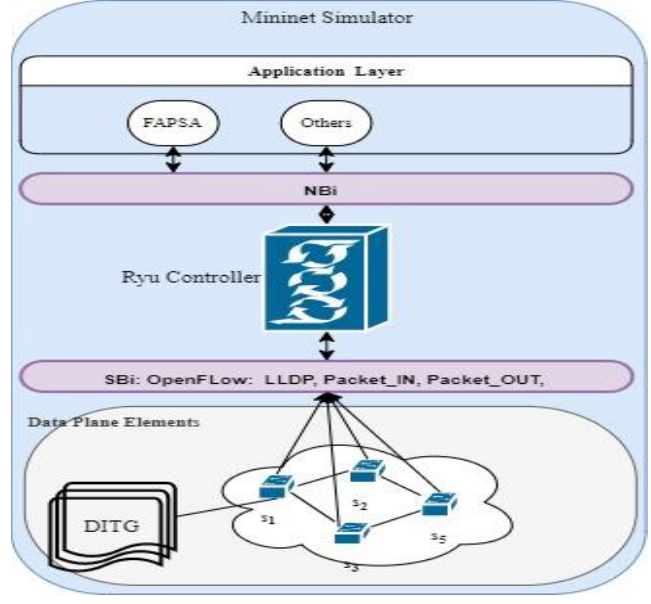
Figure 5. The architecture of simulation environment.